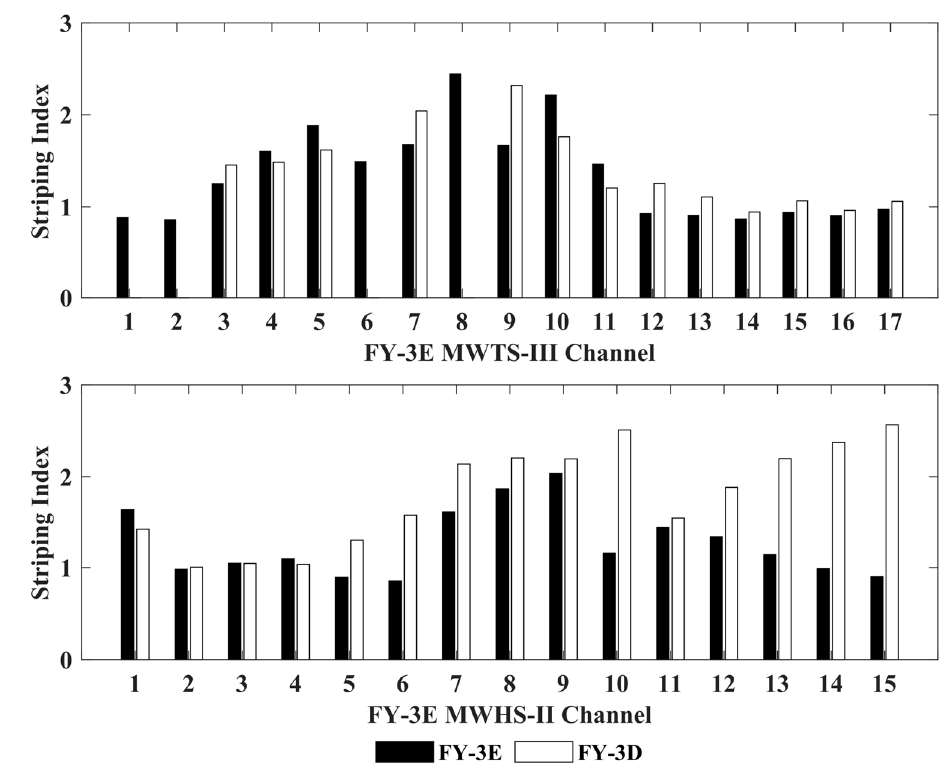
Figure 8. The striping indices estimated from one single day for each channel for comparable instruments on FY-3E and FY-3D.